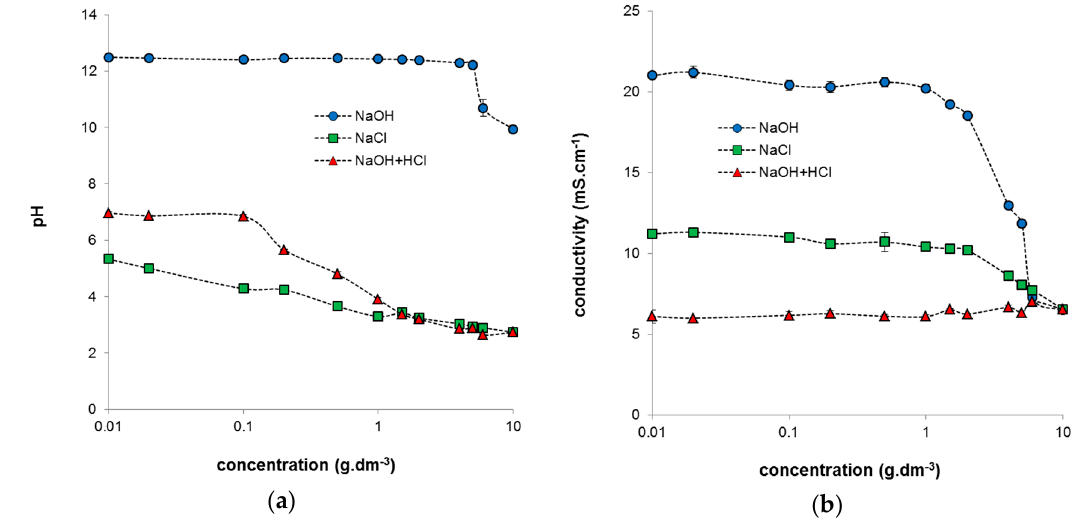
Figure 1. Obtained pH values ( a ) and conductivity values ( b ) of prepared humic sols in dependence on concentration of humic acids.